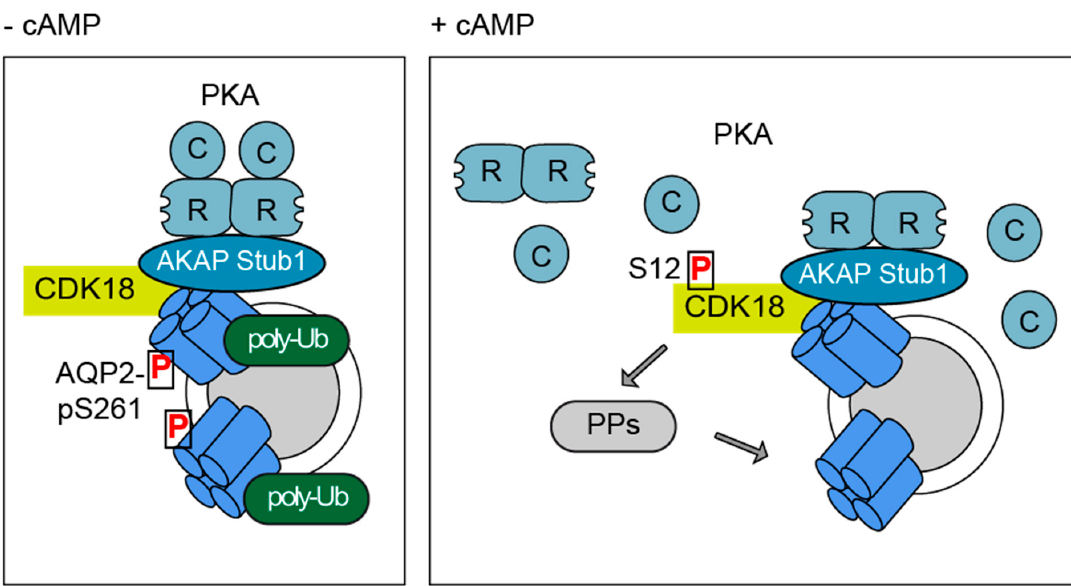
Figure 8. Model of the regulation of AQP2 by a signalosome comprising CDK18, STUB1 (E3 ubiquitin ligase and AKAP), PKA and AQP2. In resting renal principal cells (-cAMP), CDK18 maintains AQP2 phosphorylated at S261 and STUB1 maintains it poly-ubiquitinated. In this state, AQP2 is retained in cytoplasmic storage vesicles. Upon cAMP elevation, the complex directs a decrease of the S261 phosphorylation and poly-ubiquitination and hence facilitates the trafficking of AQP2-bearing vesicles to the plasma membrane. This process can involve dephosphorylation by protein phosphatases (PPs). The plasma membrane insertion of AQP2 promotes water reabsorption from primary urine and fine-tunes body water homeostasis.